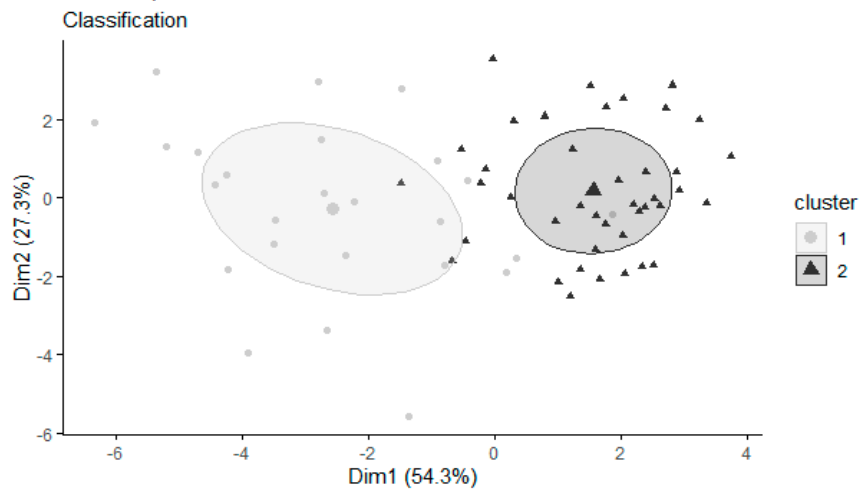
Figure 1. Classification of subjects for each cluster.